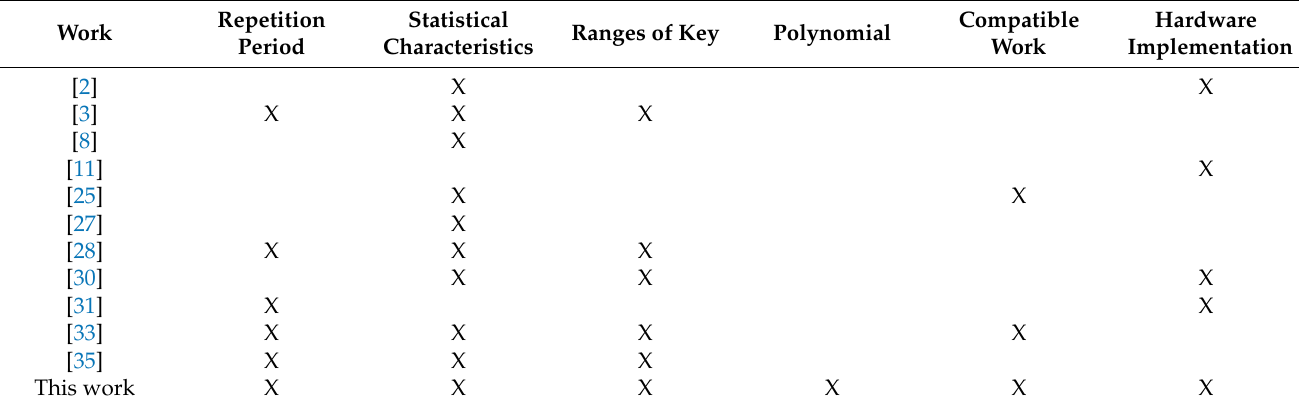
Table 1. Comparison of related work with the study in this paper.